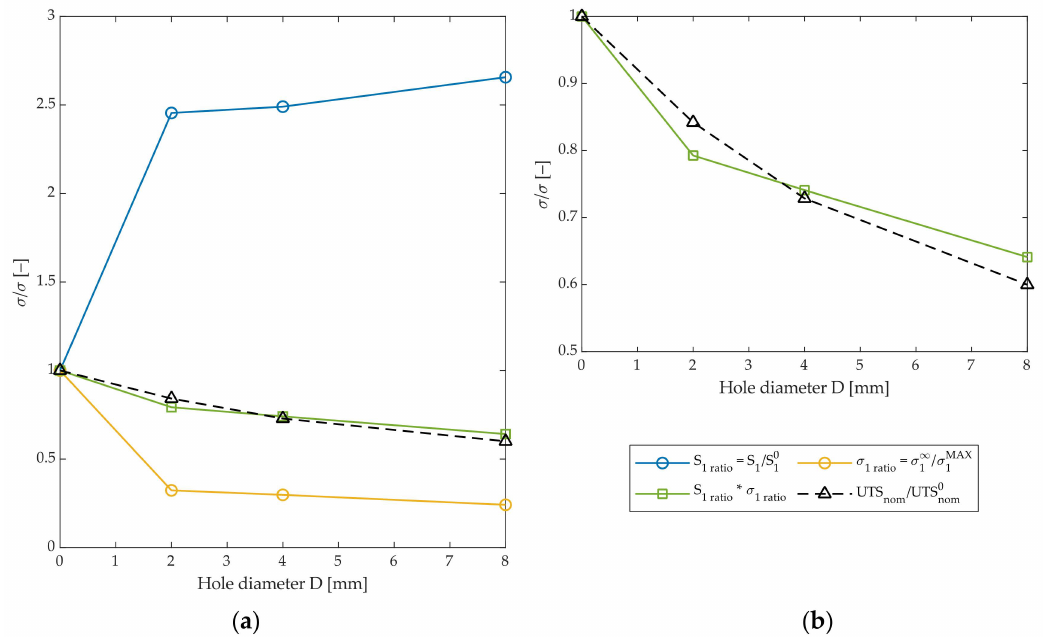
Figure 10. The two effects on stress ratios for increasing hole diameters. ( a ) Curves are the local tensile strength S 1 versus unnotched strength S 0 , remote stress versus maximum stress, their superposed 1 effect, and the macro-level trend of ultimate nominal tensile stress; ( b ) close-up of the last two